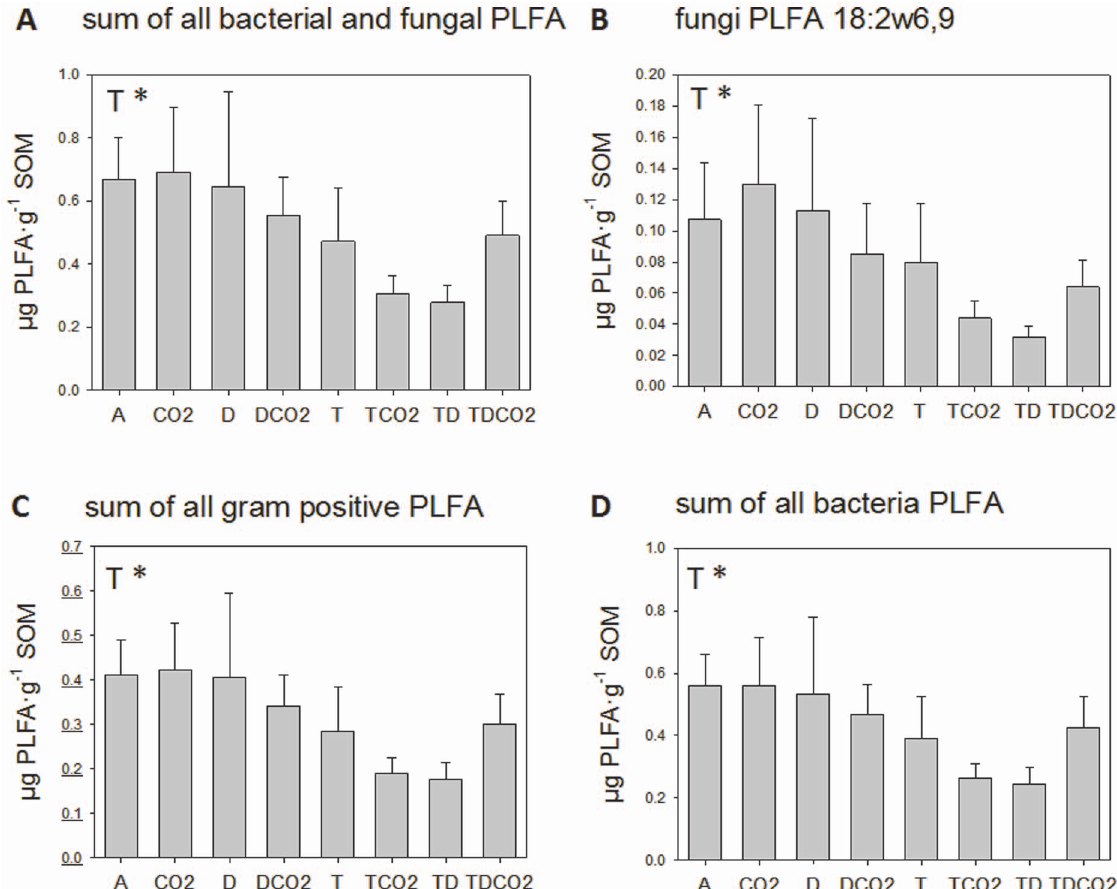
Figure 1. Concentration ( m g PLFA ? g 2 1 SOM) in top soil of PLFAs. Sum of all bacterial and fungal PLFA biomarkers ( A ); the fungal PLFA biomarker 18:2 v 6,9 ( B ); all gram positive biomarkers ( C ) and all bacteria PLFA biomarkers ( D ); one day after addition of glycine to field plots subjected to in situ treatment through one year with the climate change factors: elevated atmospheric CO 2 concentration (CO2), summer drought (D) and warming (T), and those treatments in all combinations. A is ambient control=no treatment. Error bars represent standard error. Significant effects of treatments: * is P , 0.05.